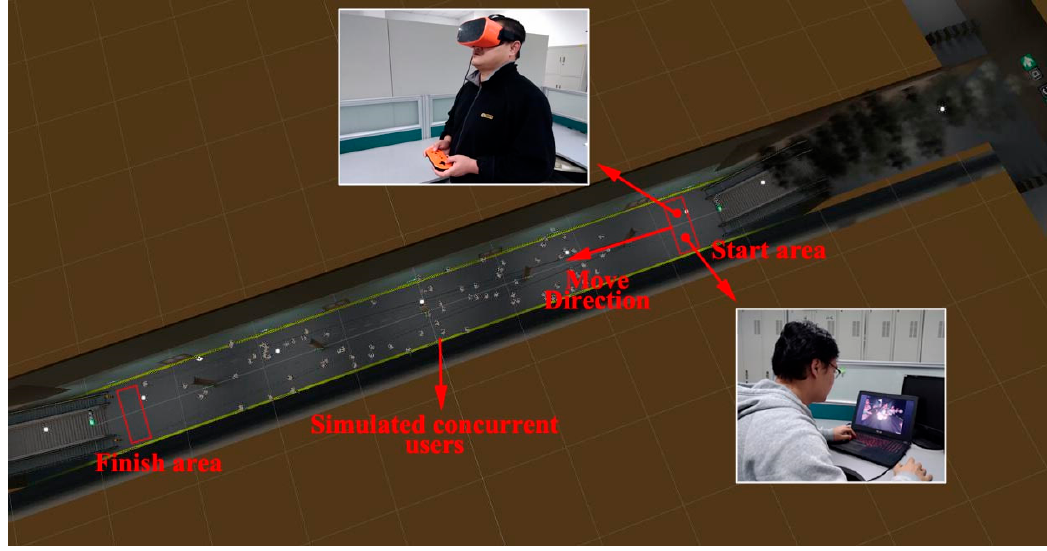
Figure 8. Overview of the performance testing process.